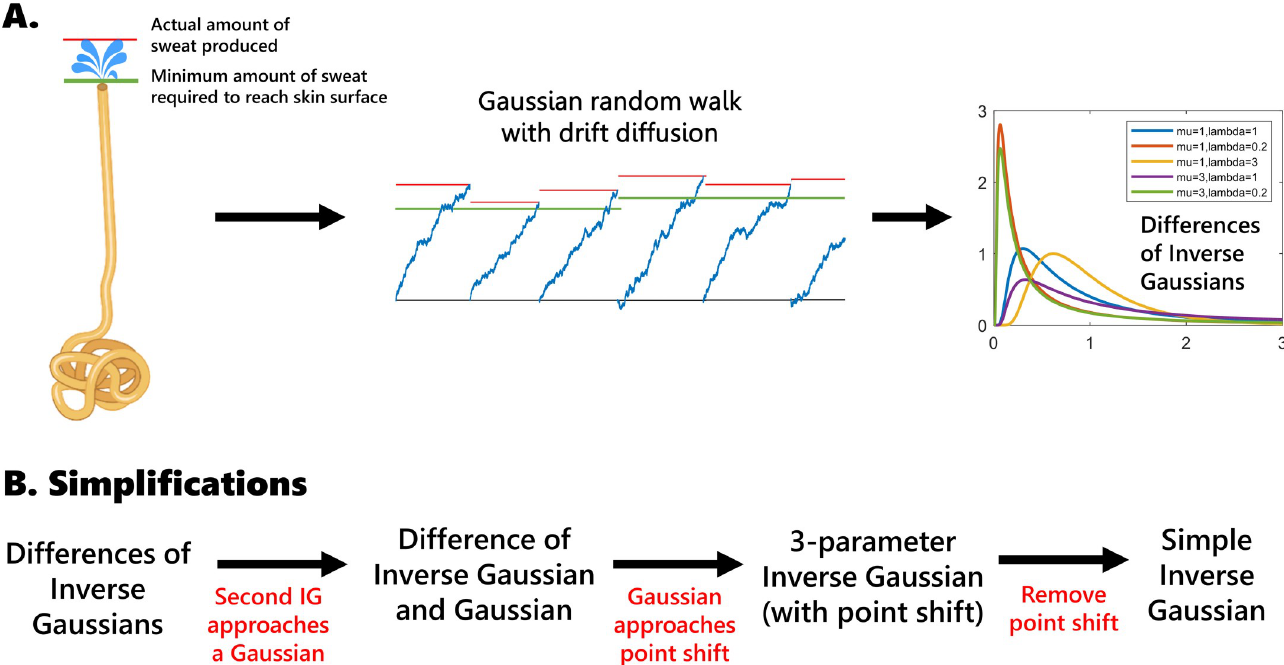
Fig 1. Schematic of our physiological hypothesis and statistical model simplifications. (A) We hypothesize that the amplitude of a pulse is related to the excess volume of sweat produced relative to what is required to reach the surface of the skin, which translates to the difference of first passage times between two integrate-and-fire processes, yielding the difference of two inverse Gaussian distributions. (B) We arrived at a series of simplifications of our model based on the statistical properties observed. IG = inverse Gaussian.